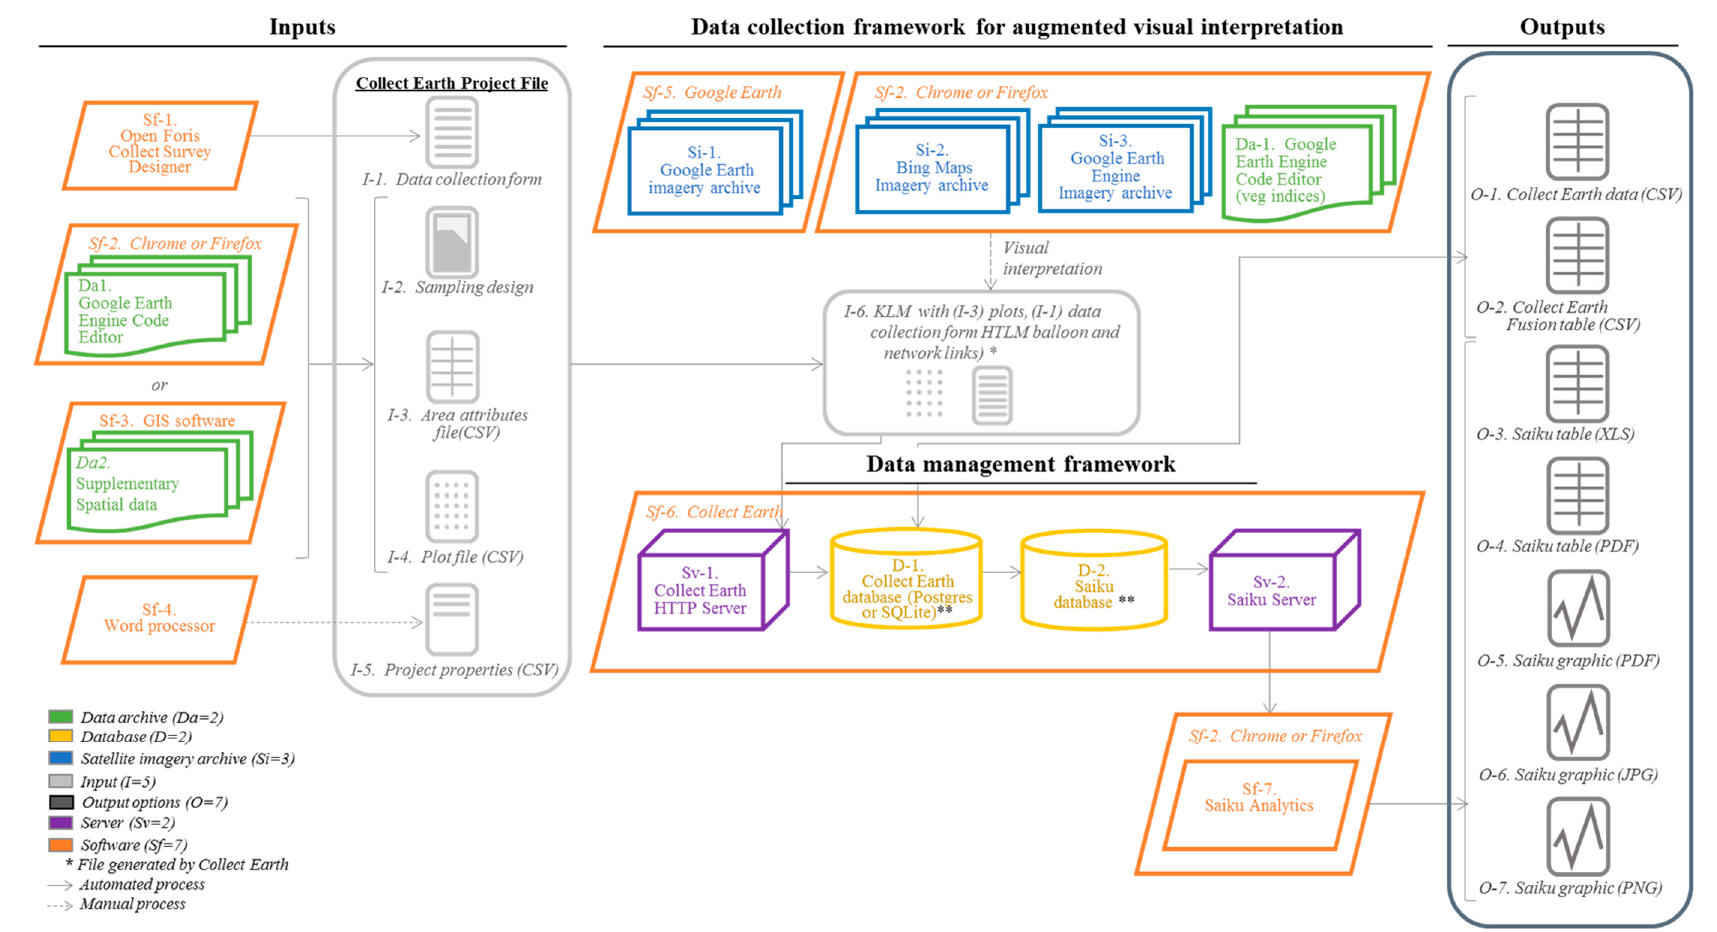
Figure 1. Overview of Collect Earth land monitoring system with supporting software.